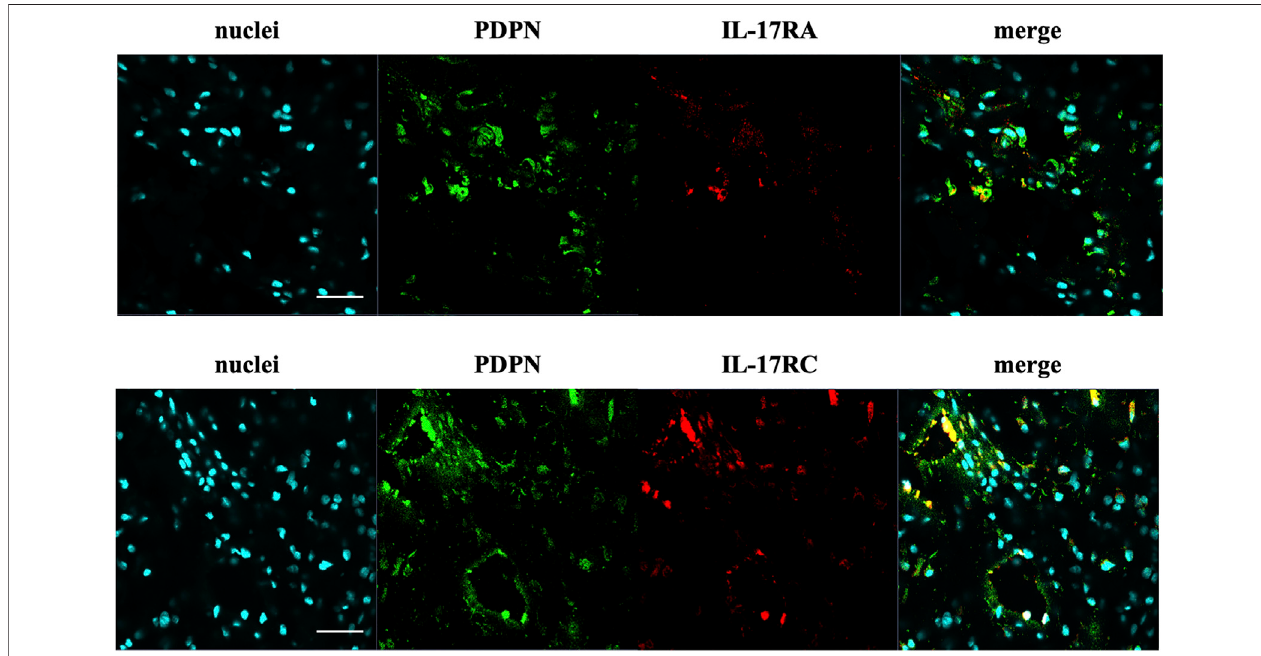
FIGURE 2 | Representative images of the protein expression of podoplanin (PDPN, green) and IL-17RA or IL-17RC (red) in supraspinatus tendons with a large/ massive tear. POPO-1 staining was used to visualise nuclei (cyan). Images taken at 40x; scale bar (cid:1) 20 μ m.